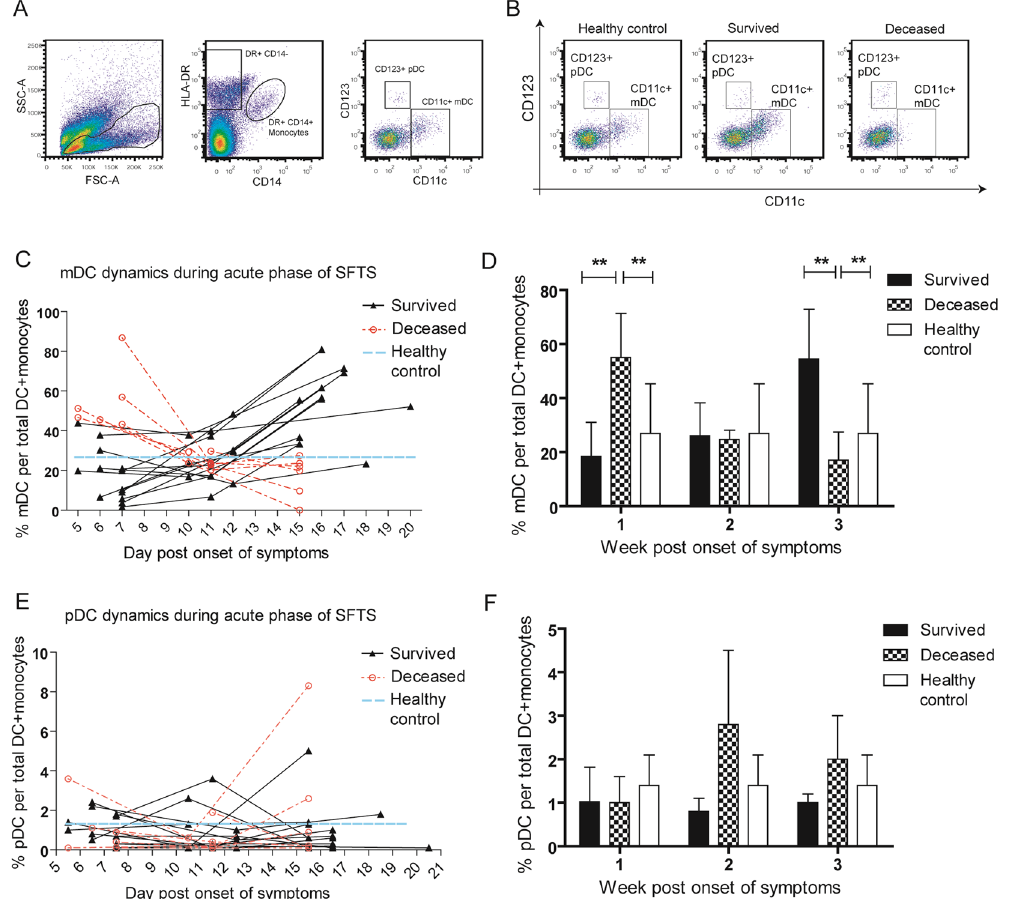
Figure 4. Dynamics of circulating myeloid dendritic cells (mDCs) and plasmacytoid dendritic cells (pDCs) during acute phase of SFTSV infected patients. The gating scheme used for identification of mDCs and pDCs in peripheral blood is shown in Fig. 4A. Three representative flow cytometry plots of mDCs and pDCs are from a survived and a deceased SFTS patients during acute phase as well as a healthy donor (Fig. 4B). Longitudinal assessments of percentage of circulating myeloid and plasmacytoid DCs in total DCs and monocytes from 13 survived and seven deceased patients during acute phase of SFTS are shown in Fig. 4C and E. Data of all day points are categorized into the first week (1~7 th day), the second week (8~14 th day) and the third week (15–21 th day) post onset of symptoms, and bar graphs (Fig. 4D and F) compare the mean ± SD of percentage of mDCs and pDCs in three different weeks. Percentage of circulating myeloid and plasmacytoid DCs in total DCs and monocytes from ten healthy donors were assessed as normal controls and were plotted in Fig. 4C and E as well as in Fig. 4D and F. * P < 0.05, ** P <